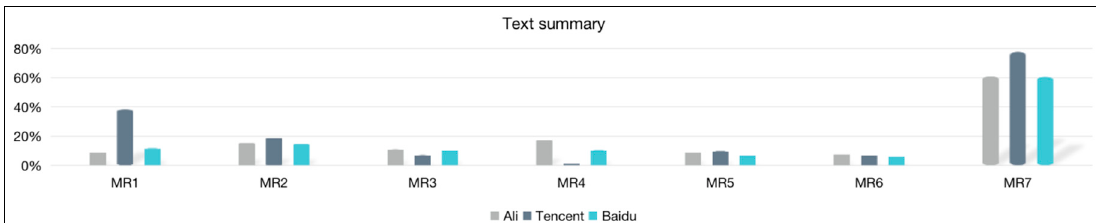
Figure 5. VR of 3 NLP systems on text similarity.